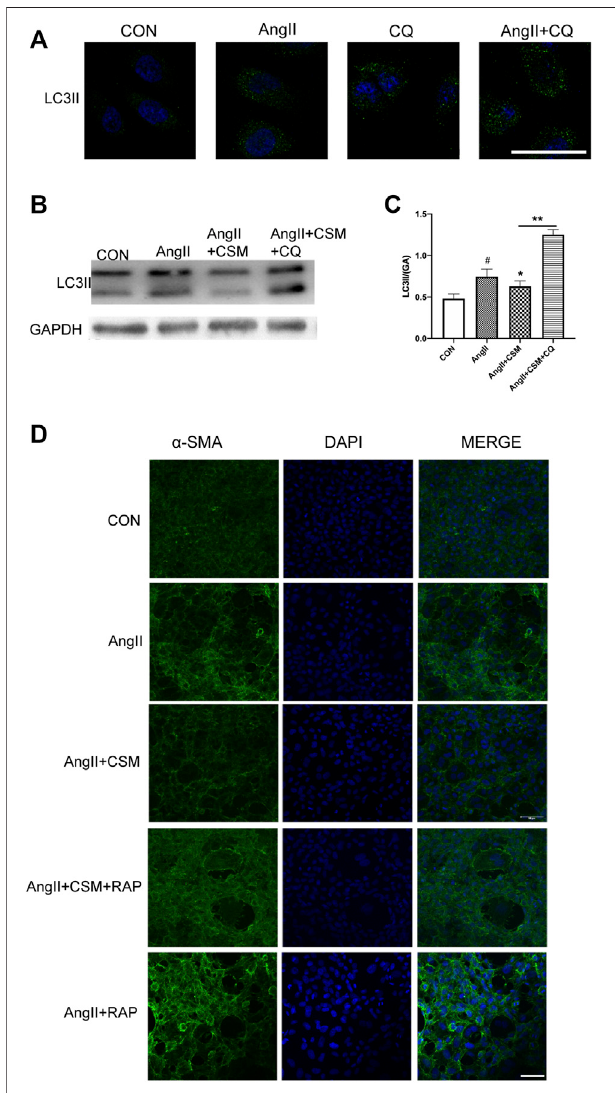
FIGURE 4 | CMS attenuated fi brosis via regulating autophagic stress in vitro . (A) NRK-52E cells were treated with AngII for 72 h, in the presence or absence of CQ (10 μ M). (B) CMS regulated autophagic stress. LC3II protein expression was assessed by western blotting. (C) Statistical results of LC3II. (D) Immuno fl uorescence images show the levels of α -SMA (green channel) for 72 h. NRK-52E cells were exposed to AngII, with or without CMS and in the presence or absence of RAP (50 nM) for 72 h. The fl uorescence intensity was detected with a laser confocal microscope, bar = 20 μ m. # p < 0.05: relative to untreated cells. * p < 0.05, ** p < 0.01: relative to the model